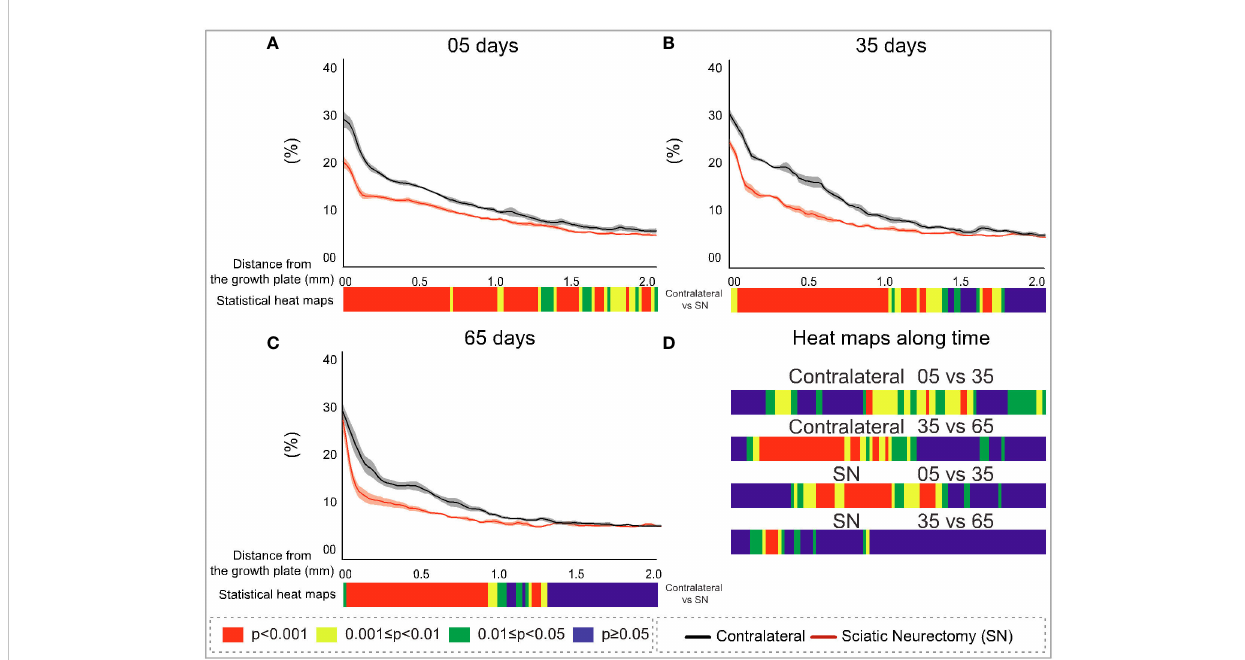
FIGURE 7 Cross-sectional (2D) percent bone area per total area (B.Ar/T.Ar) with distance from the growth plate in study B in sciatic-neurectomised (SN, red) and contralateral tibias (black) at (A) 5 days, (B) 35 days, and (C) 65 days after surgery. For all pro fi les, the SEM ranges are shown graphically. In each of the three charts, the colour bar below shows the p- value of the signi fi cance of difference (chi-square) by cross-sectional plane (downstream distance) between the left contralateral and right SN tibias. Additional colour bars (D) show if changes occurred earlier or later in the study based on the signi fi cance of difference of cross-sectional B.Ar/T.Ar with downstream distance in time-based comparisons spanning early and late time intervals for SN and contralateral control